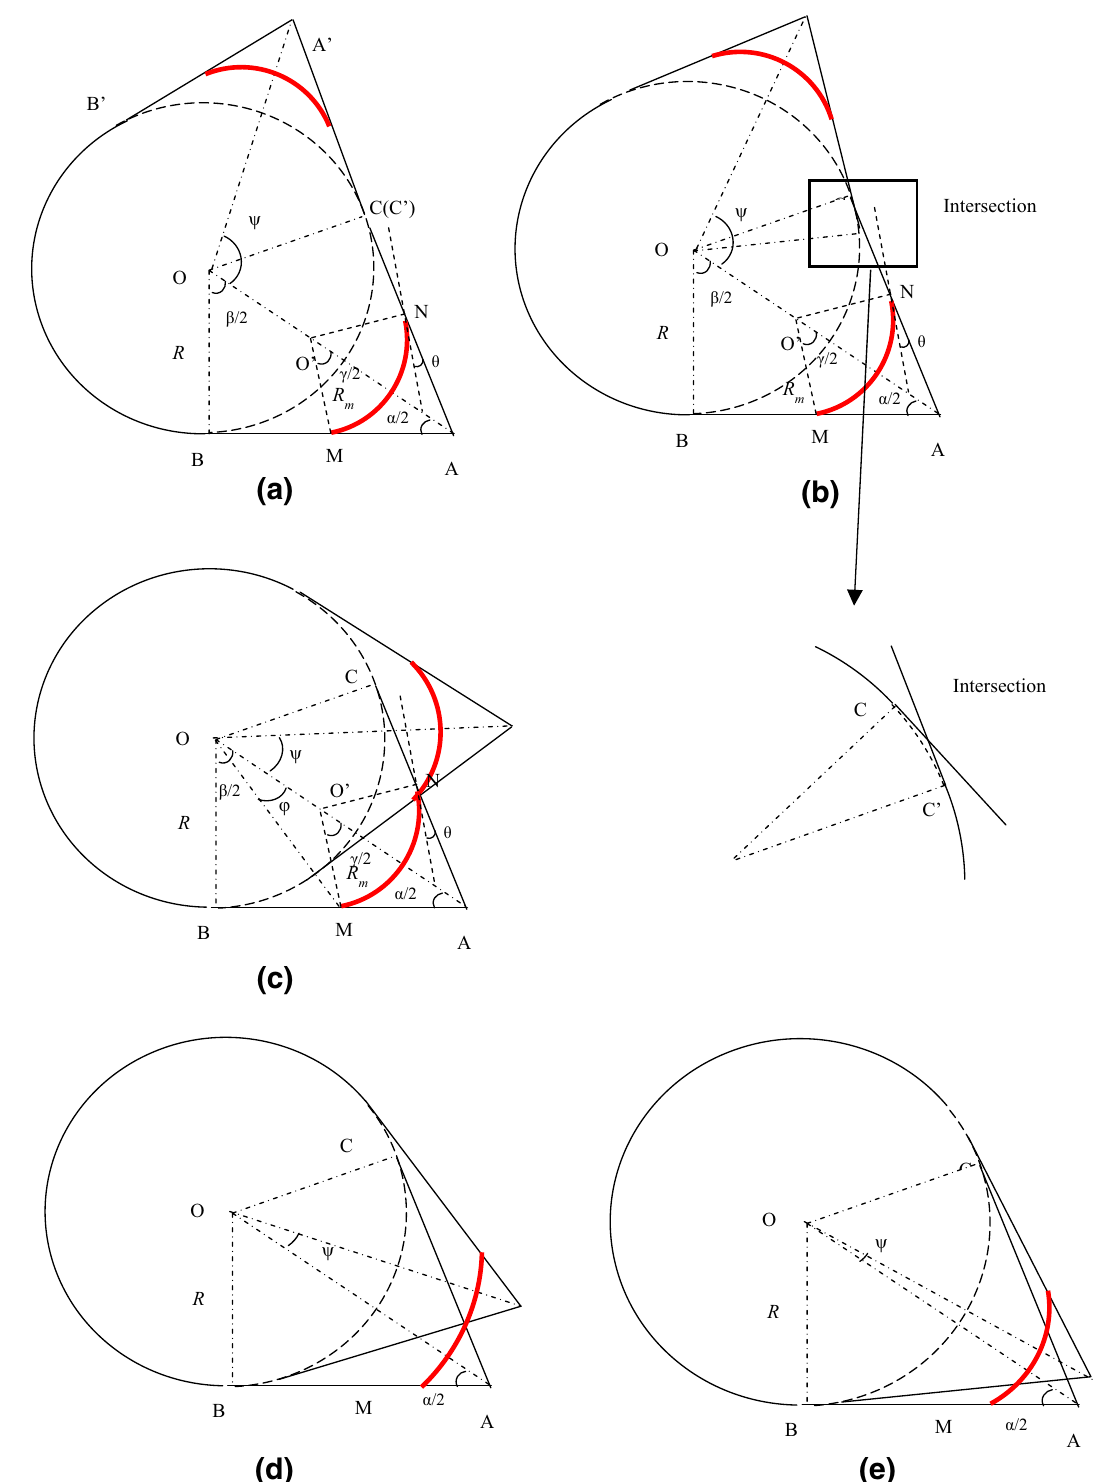
Fig. 8 Profile of various menisci when the two corners are close to each other as they rotate around the center of a